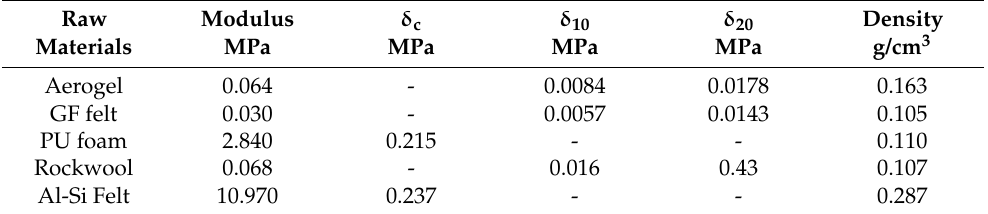
Figure 5. Stress-strain curve of different filler material. Table 6. Performance comparison of raw materials.